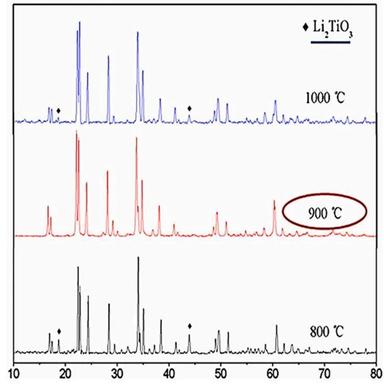
XRD patterns of the Li4Si0⋅9Ti0⋅1O4 powder samples at different temperatures.